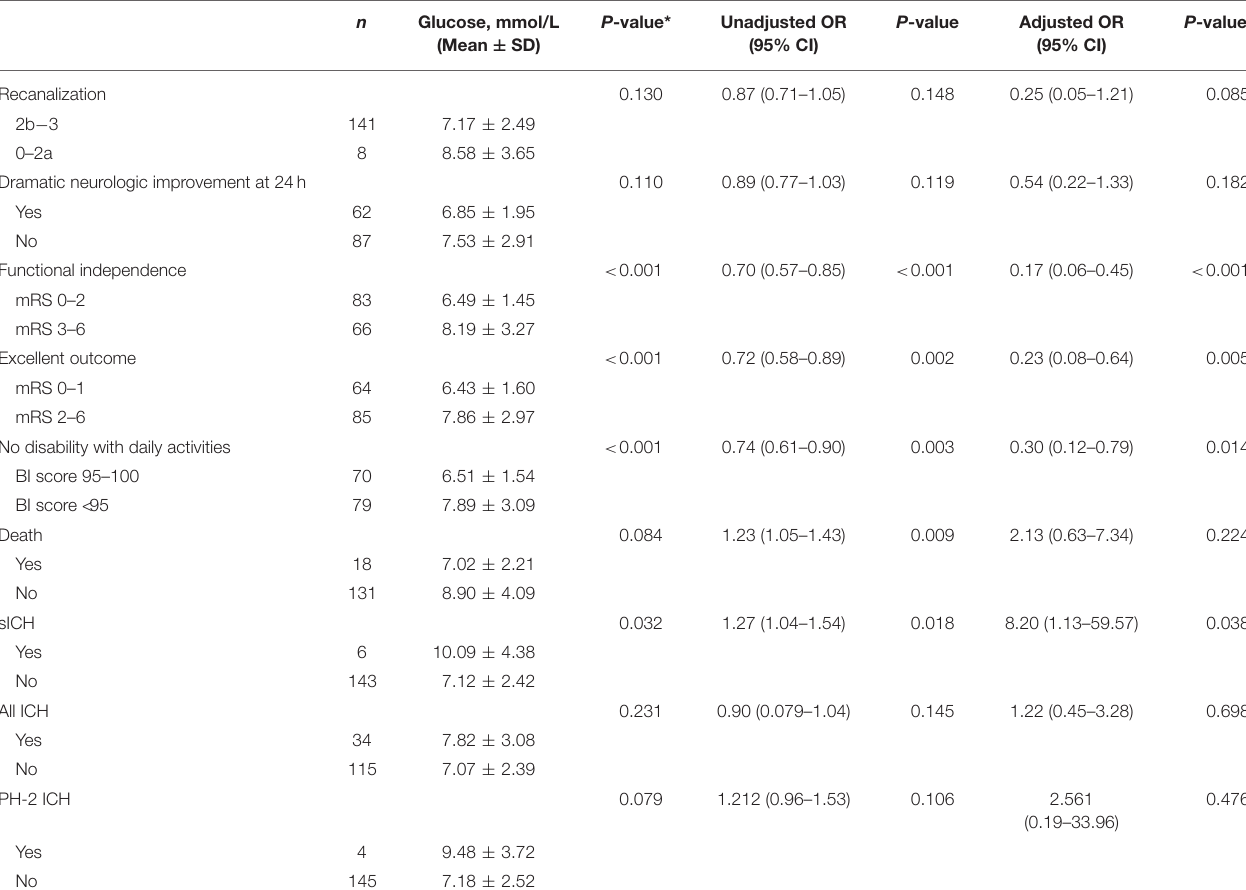
TABLE 3 | Association of glucose levels at presentation with clinical outcomes by univariable and multivariable logistic regression.